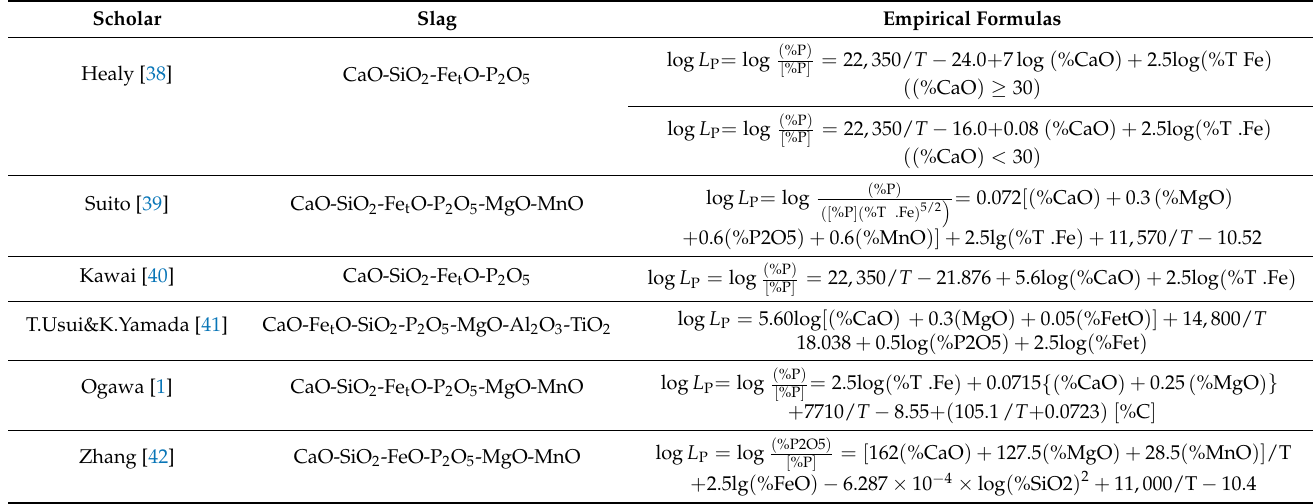
Figure 11. Comparison of log L P between the calculated value of the empirical formulas and the calculated values in this paper at different dephosphorization endpoint temperatures. Table 7. Empirical formulas of log L P